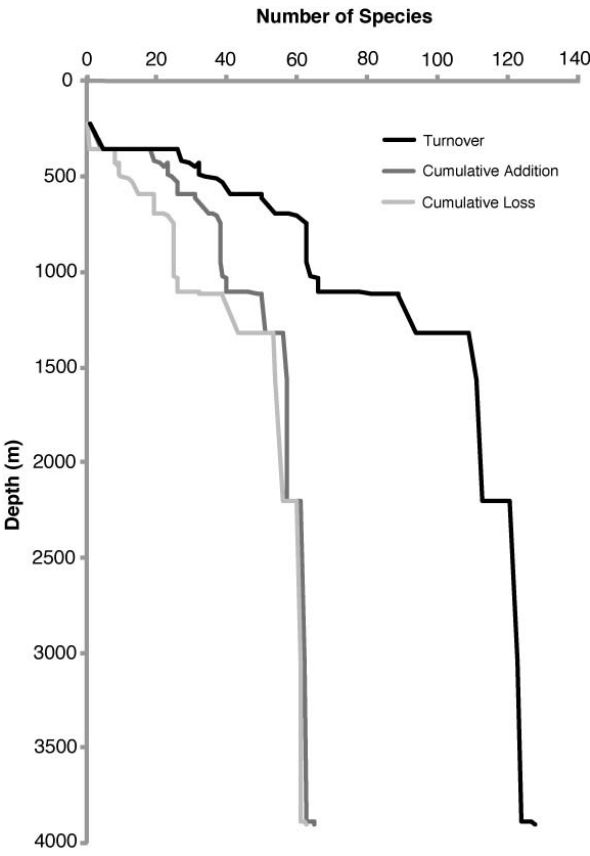
Fig. 3. Regional accumulation, loss and turnover of gastropod taxa along the depth gradient in the Gulf of Cadiz. Data from all samples and experiments are